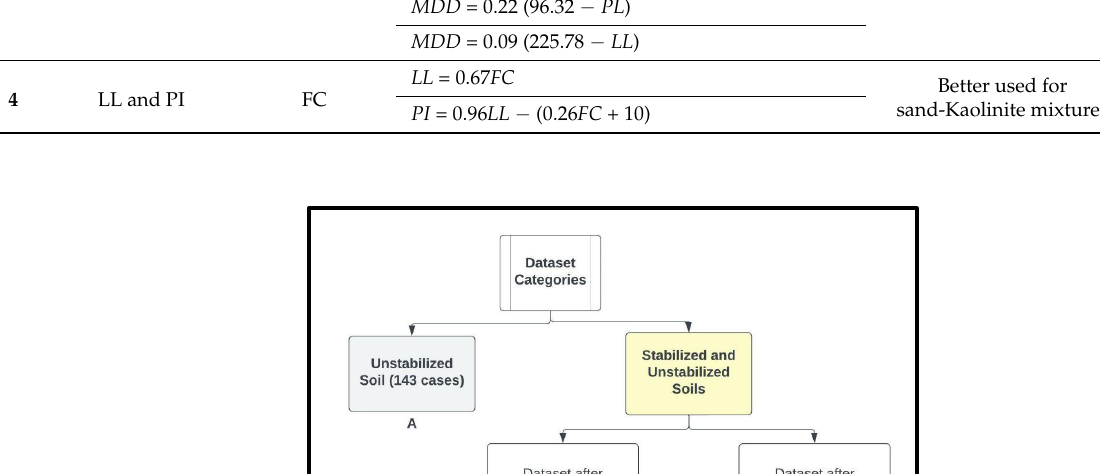
Table 5. Some correlations used for soil characteristics estimation .